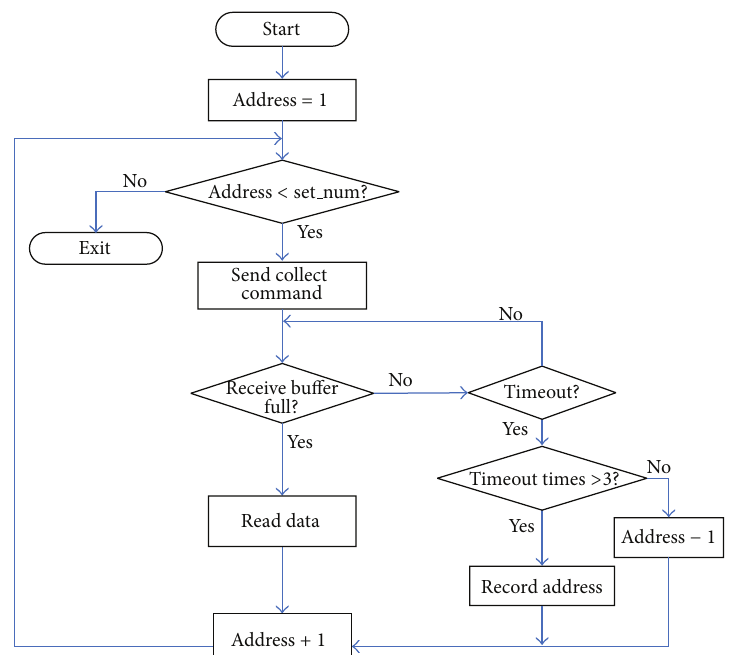
Figure 5: Flow chart of data acquisition.